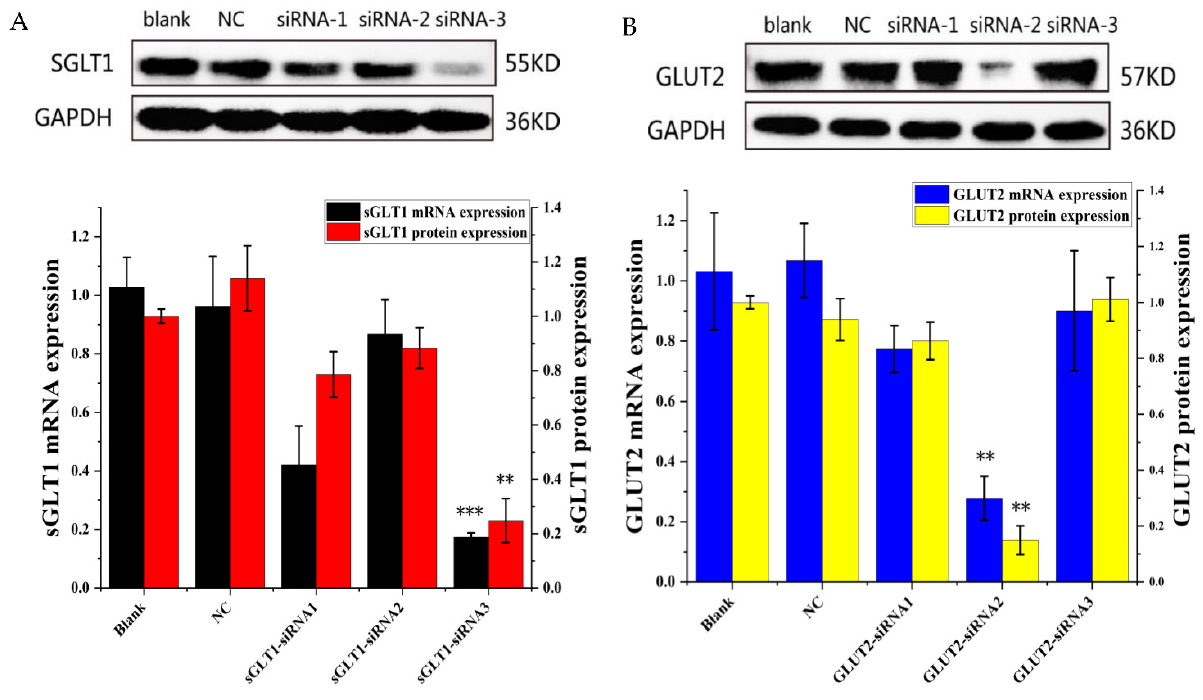
Figure 2. The expression levels of sGLT1 ( A ) and GLUT2 ( B ) in Caco-2 cells after siRNA transfection for 72 h, as detected by real-time PCR and Western blotting. blank—blank control; NC—negative control; **— p < 0.01 versus control; ***— p < 0.001 versus control.